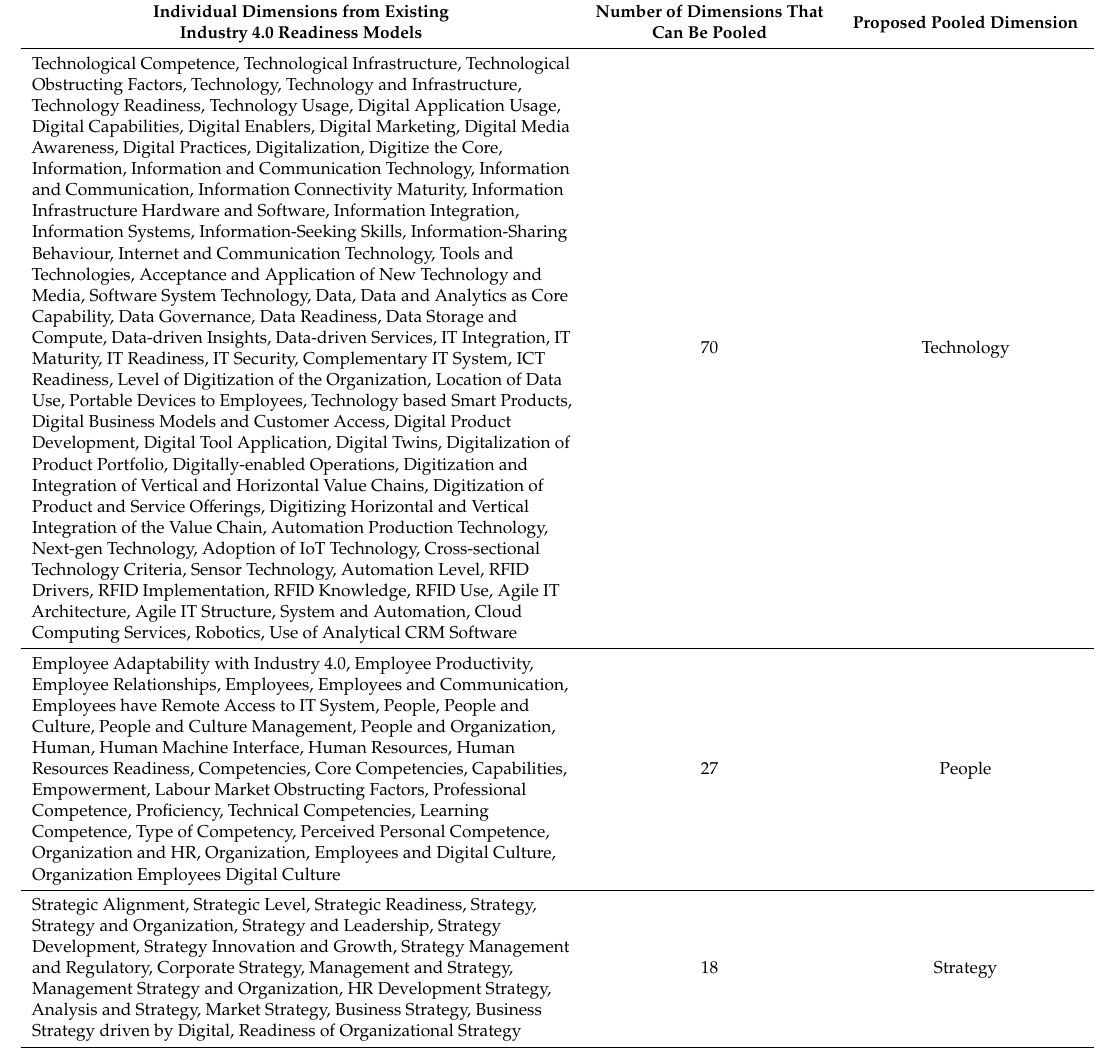
Table 4. Pooling of digital readiness model